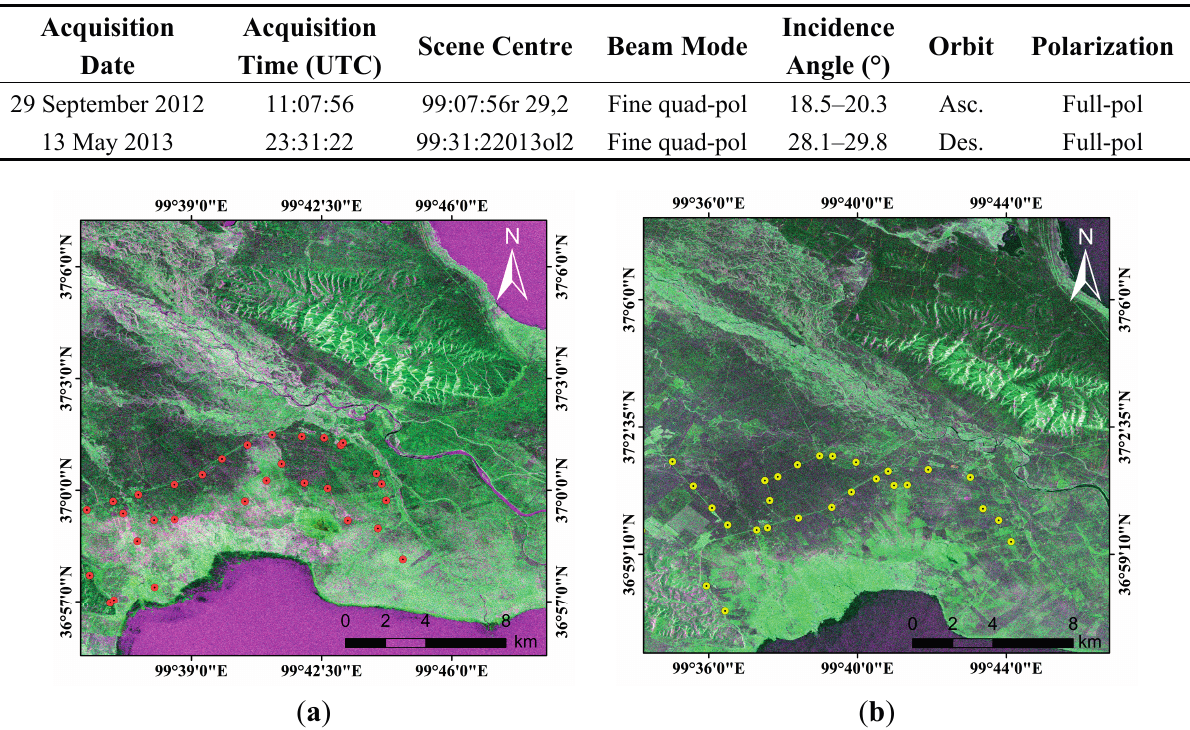
Table 1. List of the RADARSAT-2 images collected over the study area.